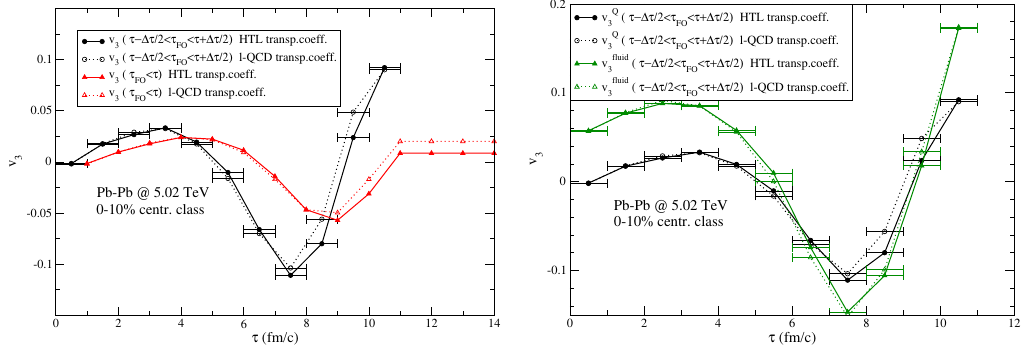
Figure 5 . The triangular (cid:13)ow of charm quarks decoupling at various values of the longitudinal proper-time (cid:28) in 0{10% Pb-Pb collisions. The (cid:12)nal integrated result (red curves with triangles in the left panel) comes from the interplay of opposite-sign contributions from the initial, intermediate and (cid:12)nal stages of the (cid:12)reball evolution. Di(cid:11)erences between results obtained with weak-coupling and l-QCD transport coe(cid:14)cients look mild. In the right panel the heavy-quark v 3 is compared to the one of the (cid:13)uid cells from which they